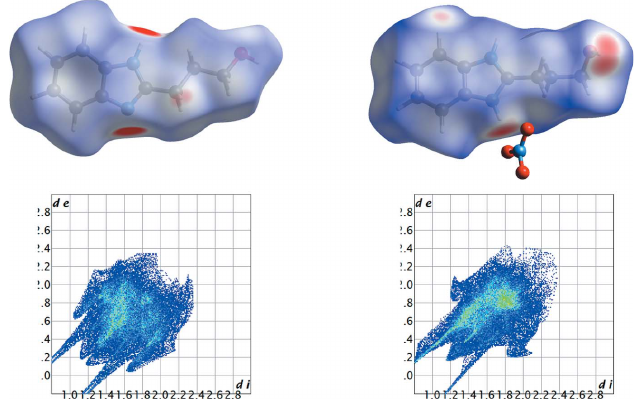
Figure 6 Hirshfeld surfaces mapped over d norm (top) and two-dimensional fingerprint plots (bottom) of the neutral 2-(3-hydroxyprop- yl)benzimidazole molecule and its protonated cation in the structures of BIZ and BIZHNO3.